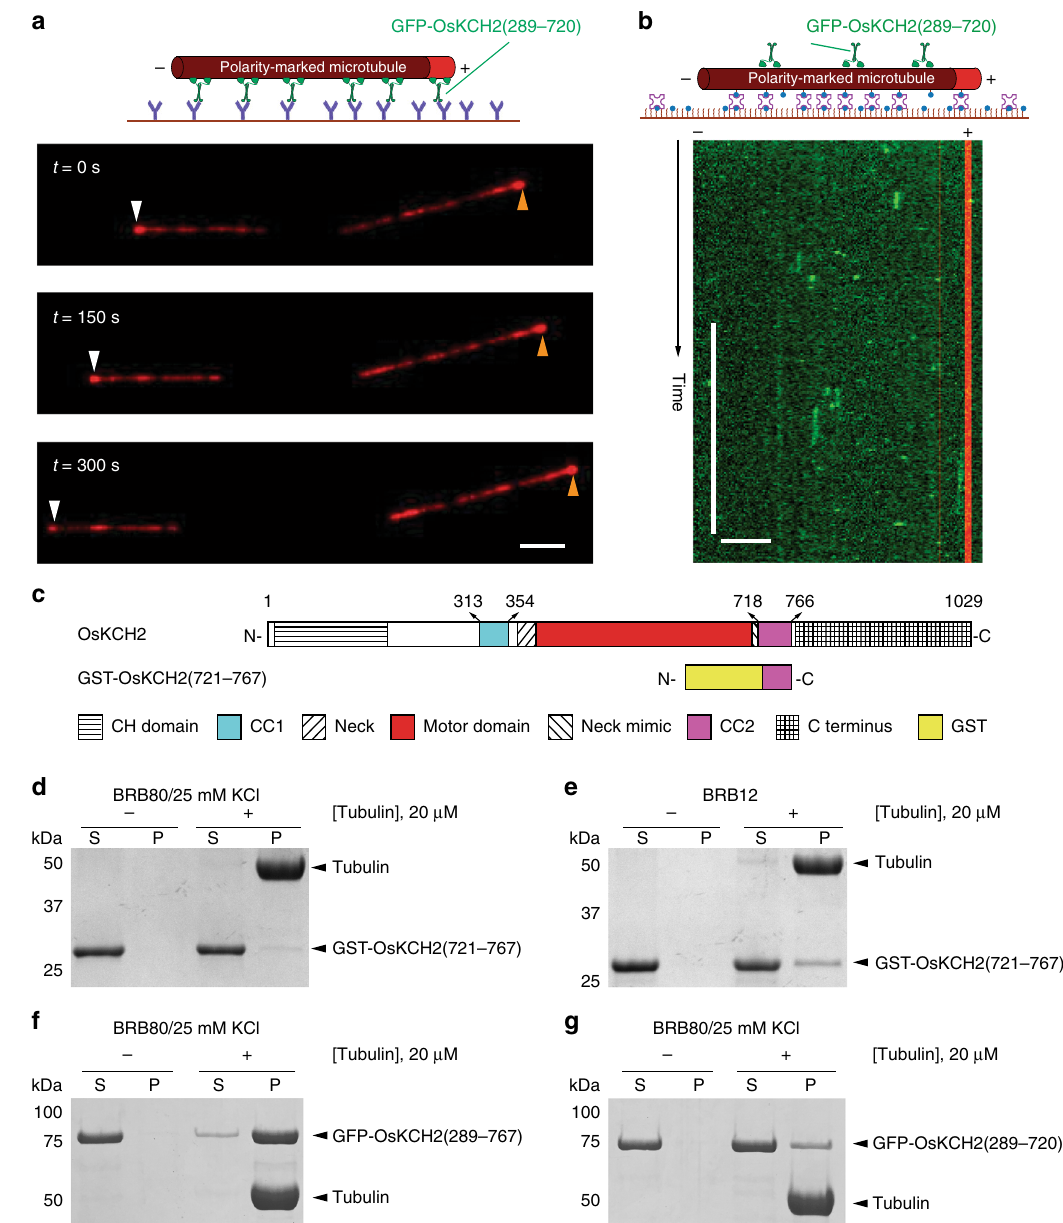
Fig. 4 CC2 enables GFP-OsKCH2(289-767) processivity by enhancing its microtubule-binding af fi nity. a Micrograph montage showing the gliding motion of polarity-marked microtubules (red) driven by surface-immobilized GFP-OsKCH2(289 – 720). White and brown arrowheads indicate the plus end of a polarity-marked microtubule at three different time points. b Example kymograph showing the nonprocessive motility of GFP-OsKCH2(289 – 720) on the microtubule. c Schematic diagrams of the full-length OsKCH2 and GST-OsKCH2(721 – 767). d Coomassie-stained SDS-PAGE of the microtubule co- sedimentation assay for GST-OsKCH2(721 – 767) in BRB80/25 mM KCl. e Coomassie-stained SDS-PAGE of the microtubule co-sedimentation assay for GST-OsKCH2(721 – 767) in BRB12. f Coomassie-stained SDS-PAGE of the microtubule co-sedimentation assay for GFP-OsKCH2(289 – 767) in BRB80/25 mM KCl. g Coomassie-stained SDS-PAGE of the microtubule co-sedimentation assay for GFP-OsKCH2(289 – 720) in BRB80/25 mM KCl. Scale bars: 30 s (vertical) and 5 µ m